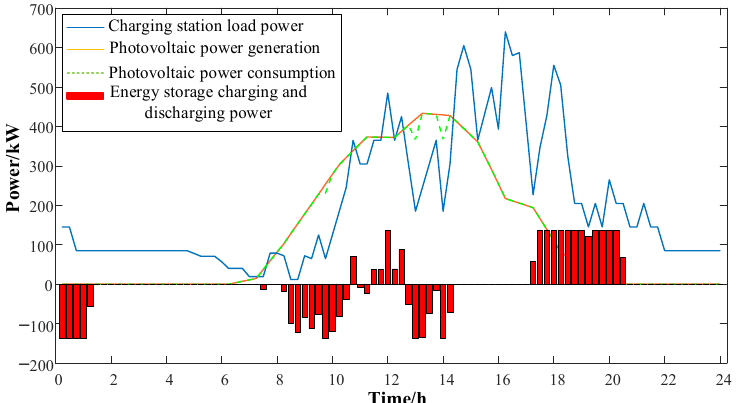
Figure 9. Load power, PV power, PV power consumption and optimal charge/discharge power curves for energy storage in Scenario II.